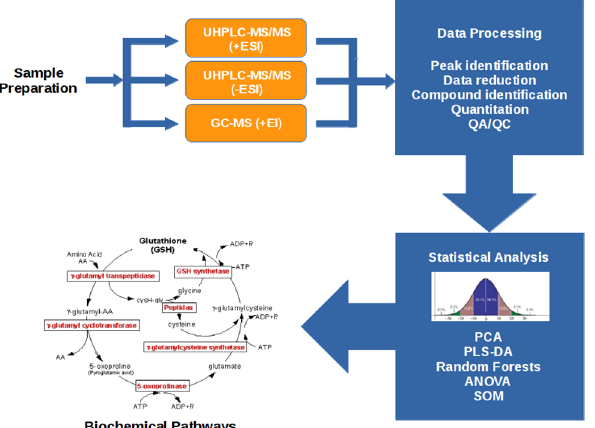
Fig 1. Workflow. This workflow provides an overview of the experimental process including sample preparation, mass spectrometric analysis, peak extraction/identification, compound quantification, statistical analysis for biomarker identification, and mapping of biomarkers to metabolic pathways. Samples were divided into separate groups for gas chromatography/ mass spectrometry (GC/MS) and LC/MS. LC/MS was further divided to examine both positively and negatively charged ions. Following data pre-processing, standard metabolite databases were used to identify metabolites and statistical tests were performed to determine significance of each metabolite in identifying dose-dependent radiation